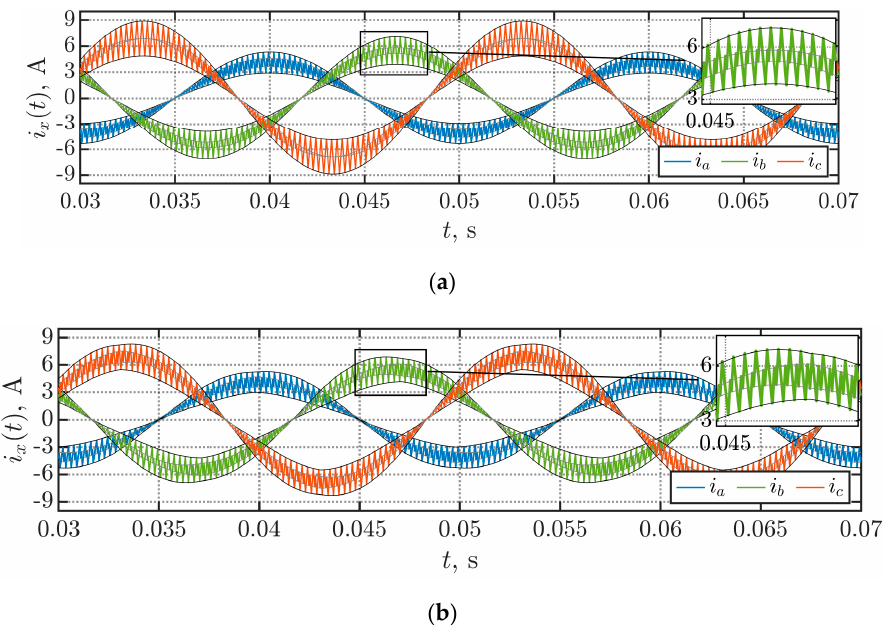
Figure 4. Phase currents in the case of modulation index unbalance ( m a = 0.3, m b = 0.4, m c = 0.5) with primary (black) and secondary (gray) current ripple envelopes for sinusoidal PWM ( a ) and centered PWM ( b ).